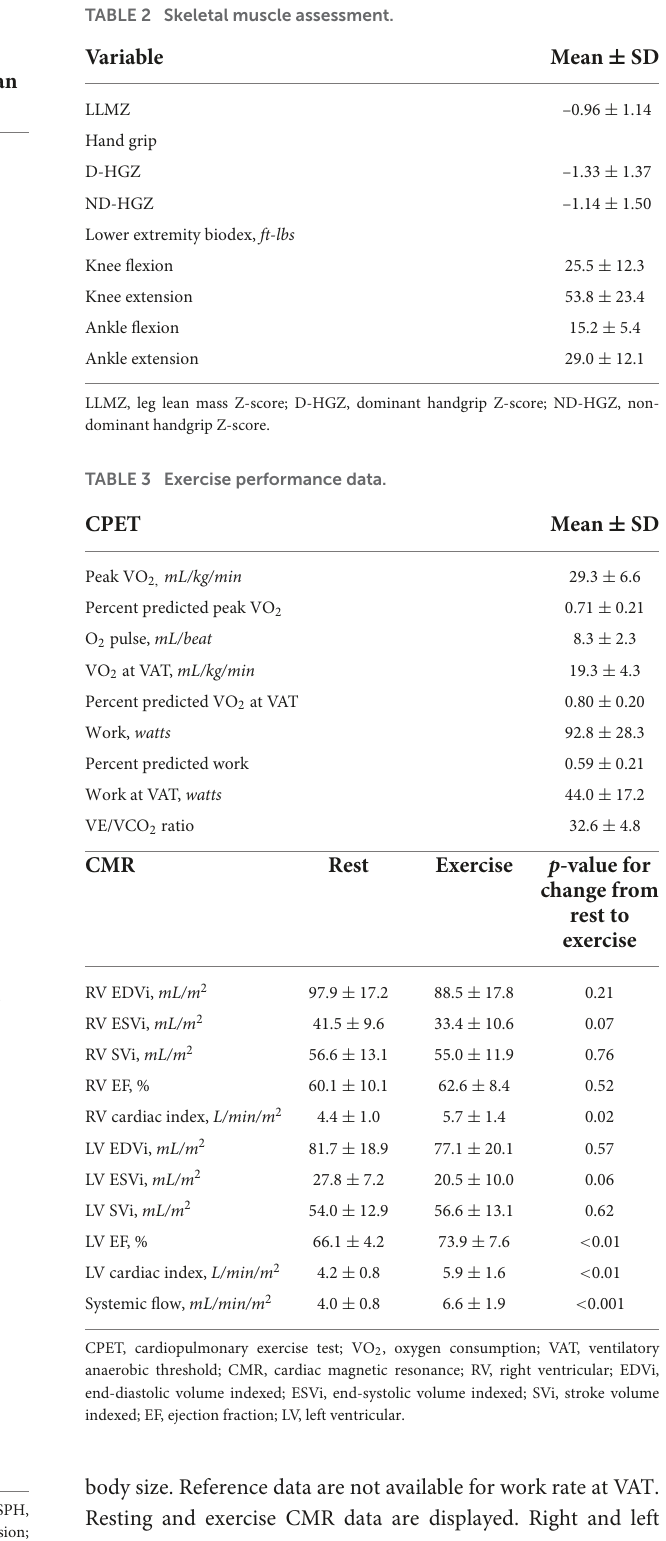
TABLE 2 Skeletal muscle assessment.